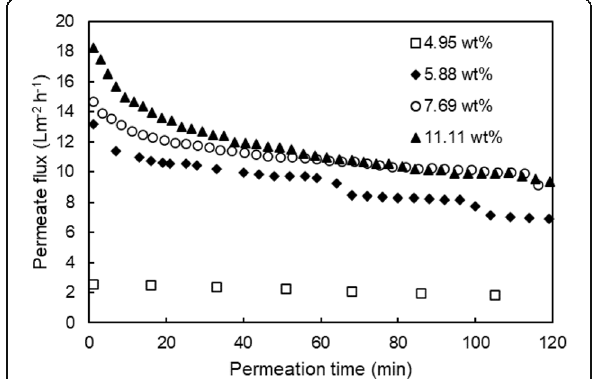
Fig. 7 Permeate fluxes of the PET membranes with various PEG 400 concentrations